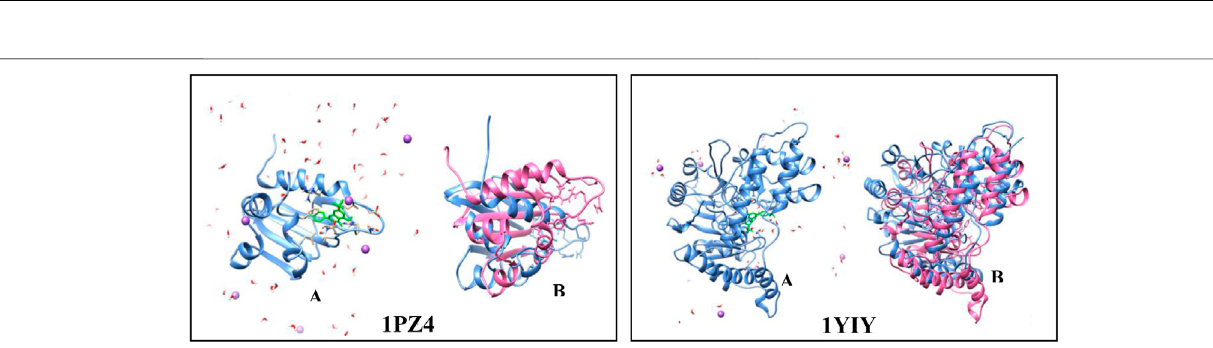
FIGURE 4 | Root-mean-square fl uctuation (RMSD) values for the C α atoms of enzymes (A) 1PZ4 and (B) 1YIY, complexed with sulfated fl avonoids and the PDB PLM ligand.